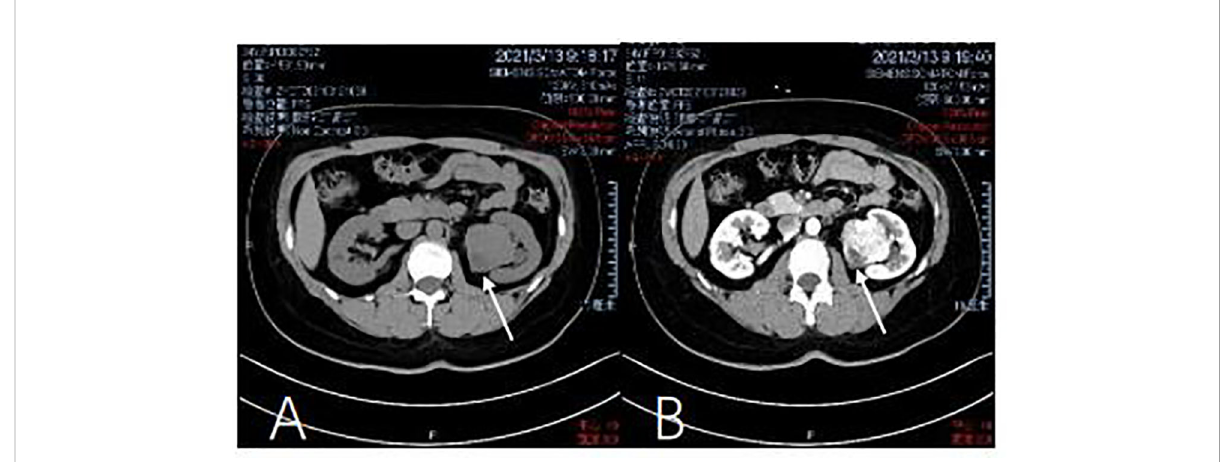
FIGURE 1 Computed tomography of the kidney. (A) Abdominal pelvis CT scan shows a mass in the left kidney. There is a no dular mass of about 4 x 3.3 x 3 cm in the middle and lower pole of the kidney. (March 13, 2021). (B) Contrast-enhanced CT shows heterogeneous enhancement in the cortical phase (March) 13,